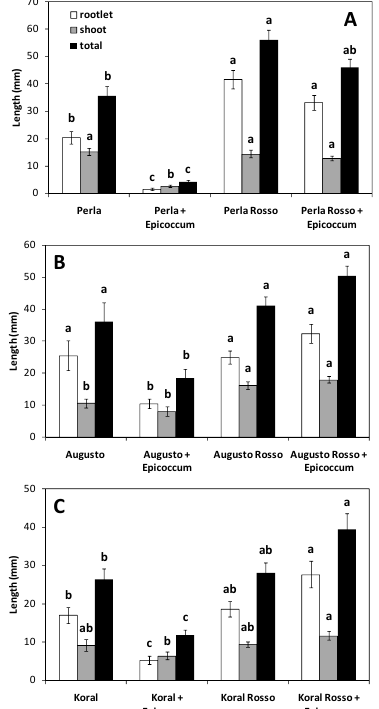
Figure 1. Seedling growth (rootlet length, shoot length, and their sum) in the presence or absence of Epicoccum nigrum for: ( A ) Perla and Perla Rosso; ( B ) Augusto and Augusto Rosso; ( C ) Koral and Koral Rosso. Dehulled caryopses were infected at 10 °C for 14–17 days and then kept at 30 °C for three days to allow rice germination and seedling growth. Values are means of five (controls) or eight (+ E. nigrum ) plates with 20 caryopses each (i.e., 100–160 caryopses) ± SE. ANOVA showed a significant effect ( p < 0.05; n = 5–8 data for each mean) of both grain type (red/white), treatment (presence/absence of E. nigrum inoculum) and their interaction, for all white/red grained genotype pairs and every measure set (rootlet length, shoot length, and their sum) but for the treatment effect (on rootlet length, shoot length, and their sum) in both the Augusto and Augusto Rosso pair and Koral and Koral Rosso pair, as well as the interaction effect on shoot length in the Augusto and Augusto Rosso pair. For each white/red grained genotype pair and within each measure set (rootlet length, shoot length, and their sum), values with the same letter are not significantly different ( p ≤ 0.05; Tukey’s test; n = 5–8 data for each mean).